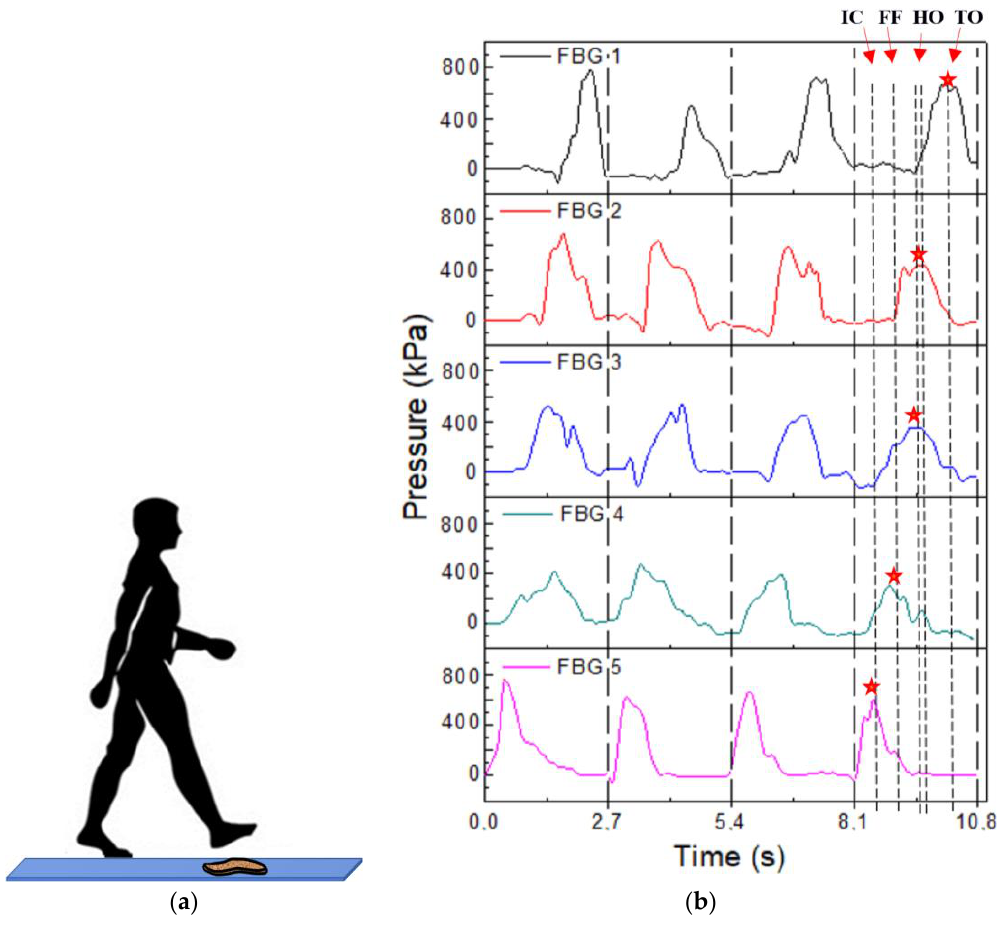
Figure 4. ( a ) Schematic diagram of the protocol implemented for the gait analysis using the fixed platform. ( b ) Pressure obtained during the four steps for the 5 POFBGs, in which the periods of stance phase (short dashed lines and star symbols) can be observed. IC: initial contact; FF: flat foot; HO: heel off and TO: toe off.